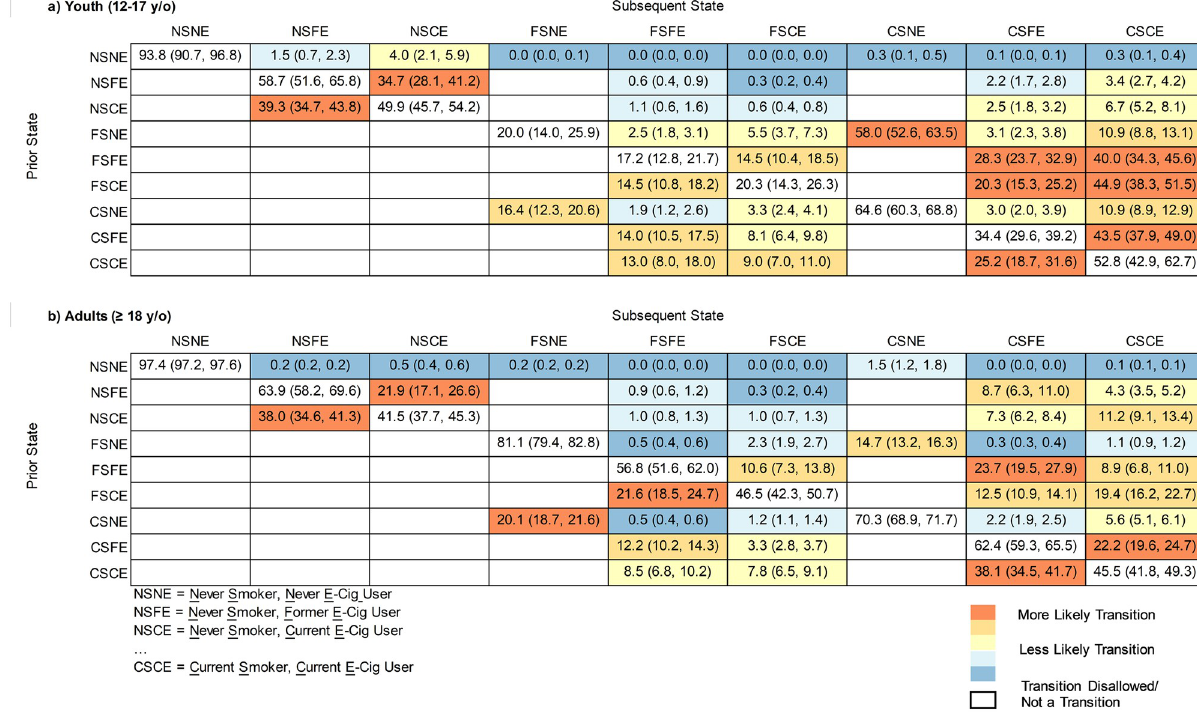
Fig 3. Annual cumulative transition probabilities according to the continuous-time Markov multi-state model for (a) youth and (b) adults. Data are presented as the probability, among those in the indicated prior state (row), of being in the indicated subsequent state (column) one year later. In parentheses are the 95% confidence intervals. More likely transitions are pictured in orange, while less likely transitions are pictured in blue. Note that participants may experience more than one instantaneous transition in sequence within the year, meaning that some transitions that cannot occur instantaneously (e.g., NSNE to FSFE) are nonetheless allowed as annual cumulative